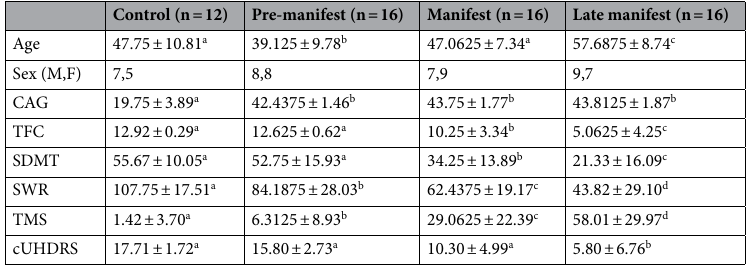
Table 1. Participant baseline demographics by disease stage. Differences in baseline demographic variables were identified using a 1-way ANOVA with post-hoc testing after determination of a significant main effect (p < 0.05). Participant age is reported in years as well as the proportion of males to females (M,F). The number of trinucleotide repeats (CAG) as well as performance on total functional capacity (TFC), symbol digit modality test (SDMT), stroop word reading (SWR), total motor score (TMS) and the compositive United Huntington Disease Rating Scale (cUHDRS) scores are reported here as mean ± S.D and values that do not significantly differ share a